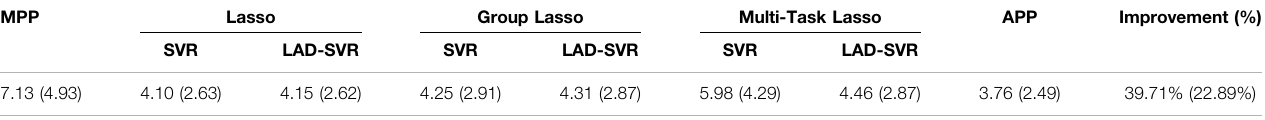
TABLE 2 | The number of corrections required by surgeons on average (standard deviation) to the different types of preoperative plans. MPP